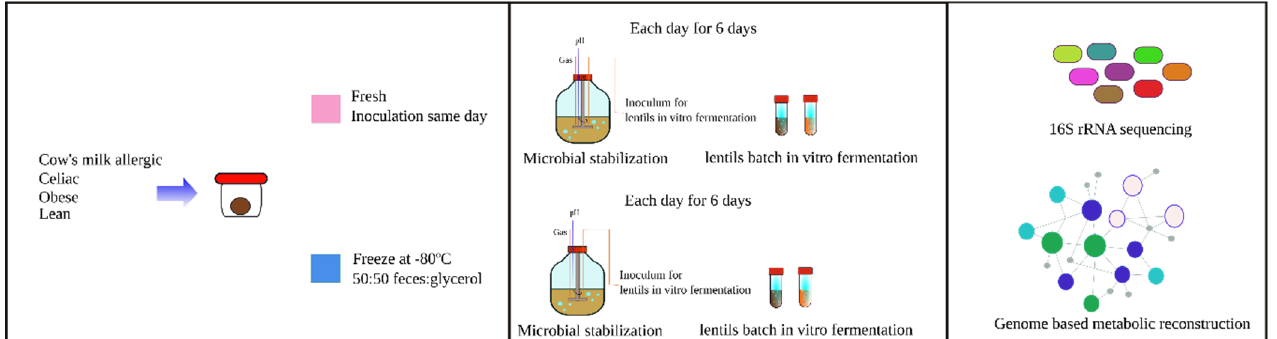
Figure 1. Scheme of the experiment.